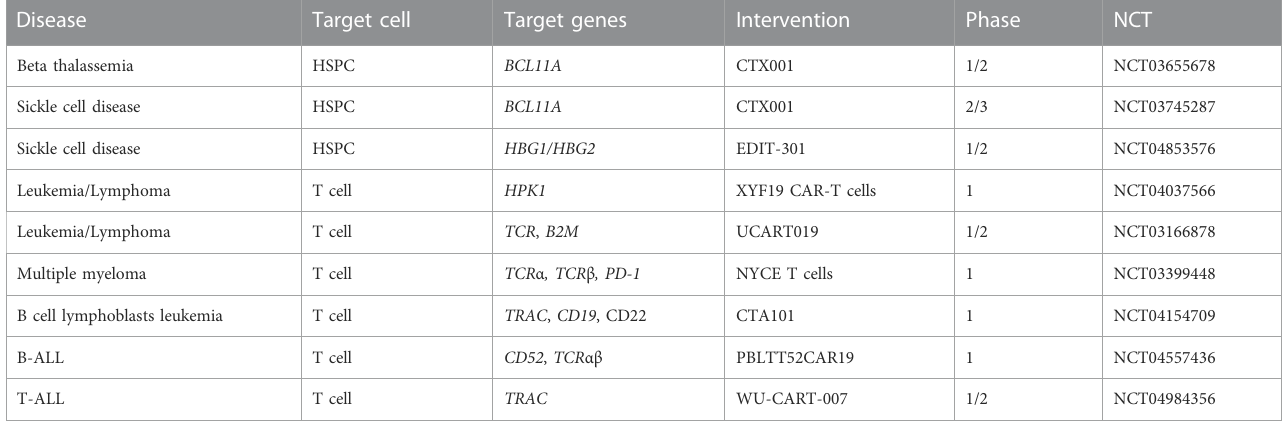
TABLE 1 Clinical CRISPR based gene therapy trials using electroporation as delivery system.